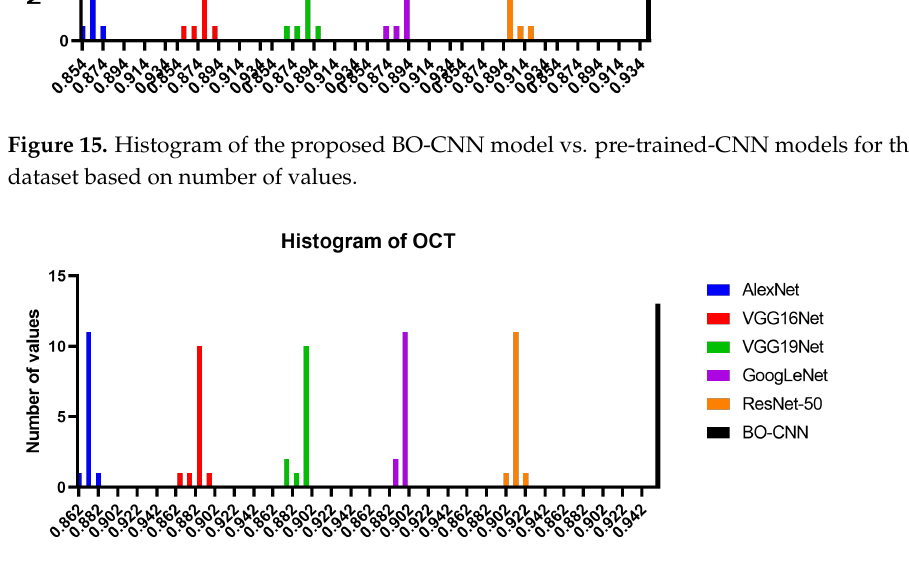
Figure 16. Histogram of the proposed BO-CNN model vs. pre-trained-CNN models for the OCT dataset based on number of values.